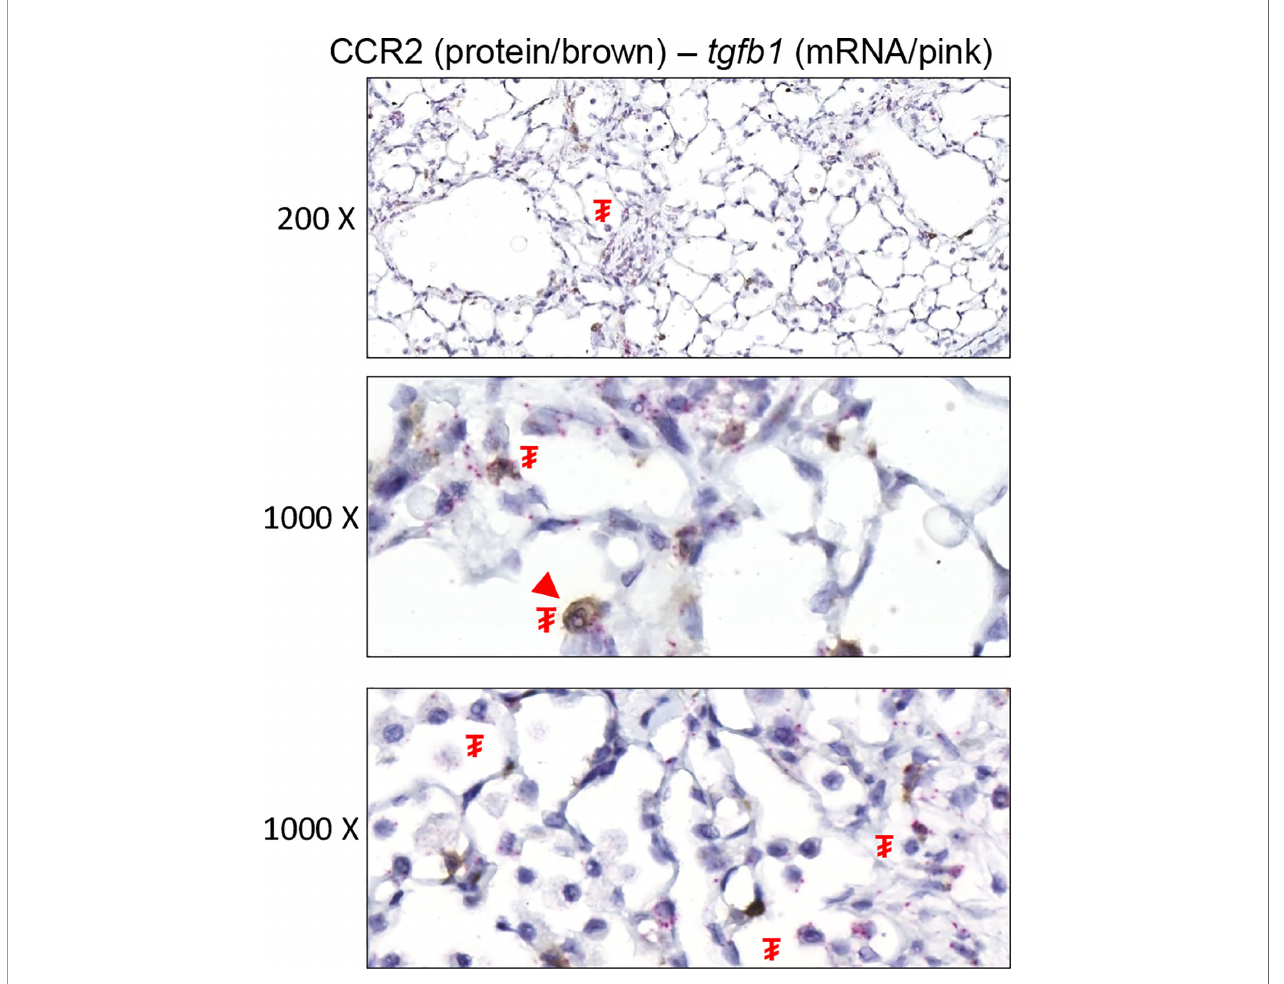
FIGURE 4 | Tgfb1 expression in CCR2 + cells following SP-C I73T induced injury. In situ hybridization ( tgfb1/pink ) combined with immunohistochemistry (CCR2/brown) analysis of SP-C I73T CCR2 WT lung 14 d after injury. ₮ indicates area expressing tgfb1; arrowhead indicates CCR2 staining cells. Representative 200x (top) and 1000x (bottom) images from N = 3 separate animals are